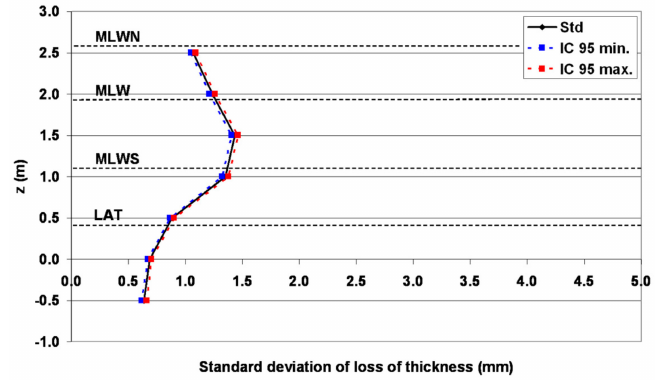
Figure 9. Standard deviation of loss of thickness according to z—BO1.